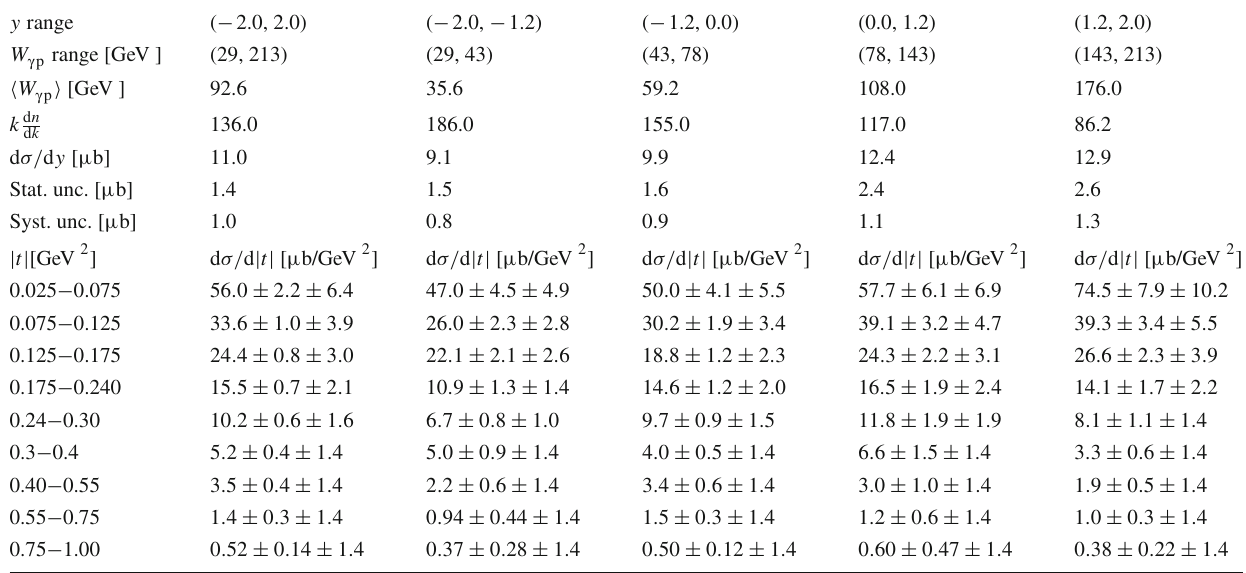
Fig. 7 The slope parameter b extracted from the exponential fits of + − < the differential cross sections d σ/ d | t | shown as a function of W γ p . The π π innererrorbarsshowthestatisticaluncertainty,whiletheoutererrorbars indicate the statistical and systematic uncertainties added in quadrature. The dashed line shows the result of the Regge fit discussed in the text < 213 GeV. The results of-mass energy interval 29 < W γ p are consistent with those of the H1 and ZEUS Collaborations at HERA, indicating that ion–proton collisions can be used in the same way as electron–proton ones, with ions acting as a source of quasi-real photons. The combination of the present data and the earlier, lower energy results agrees with theory-inspired fits. The differential cross section d σ/ d | t | for ρ ( 770 ) 0 photoproduction is measured as a function of W γ p . (cid:4) W (cid:5) , and k d n γ p , γ p d